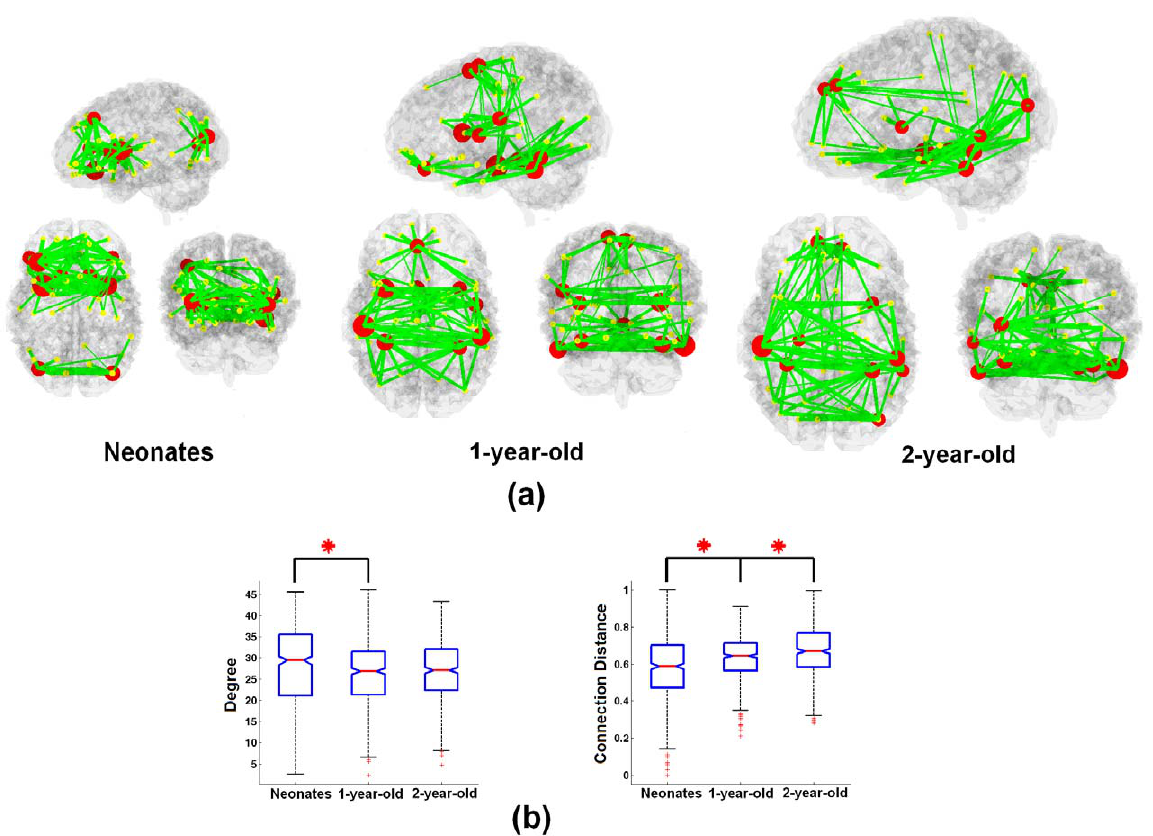
Figure 4. The temporal and spatial evolution of brain hubs during the first two years of life. (a) Spatial distribution of the top 10 hubs and their associated connections at cost 10% (based on the group-mean connectivity matrix) is shown; (b) The degree and maximum connection distance (MD) of the top 10 hubs are compared across different age groups. Red asterisks represents significant difference at p , 0.05 (FDR correction).